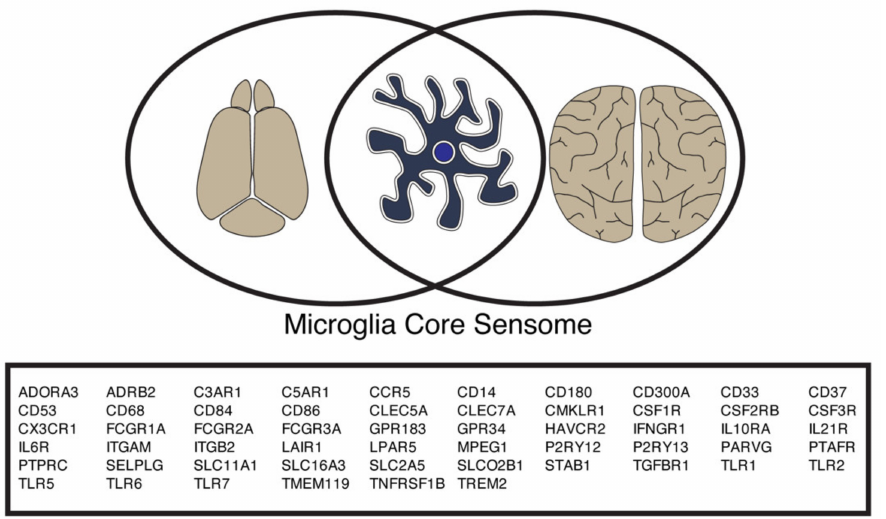
Figure 4. The mouse sensome and human sensome share similarities and differences. Overview of the microglia core sensome genes as identified by the overlap of human and mouse microglial